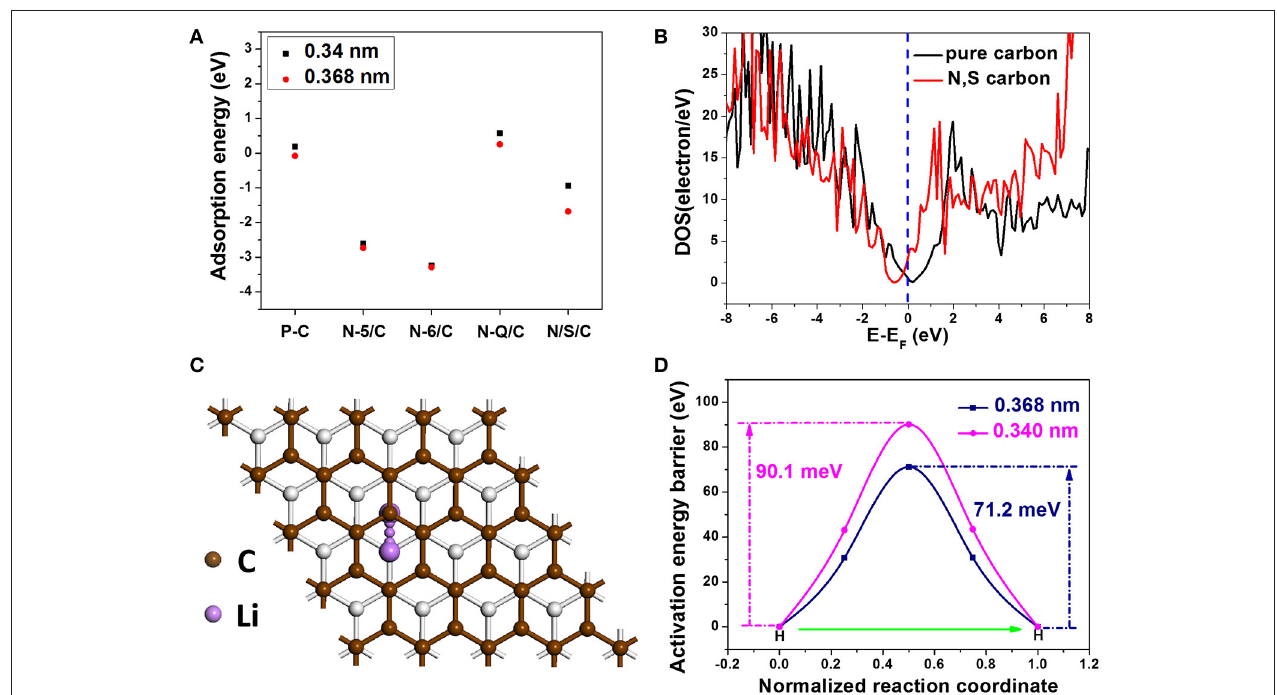
FIGURE 5 | Adsorption energy for the different carbon systems with interlayer spacing of 0.340 and 0.368 nm: P/C, N-6/C, N-5/C, and N/S/C; (B) Density of states of the pure carbon and N, S co-doped carbon; (C) Illustration of a specific Li ion diffusion path; (D) Activation energy barrier curves for the carbon systems with interlayer distance of 0.368 and